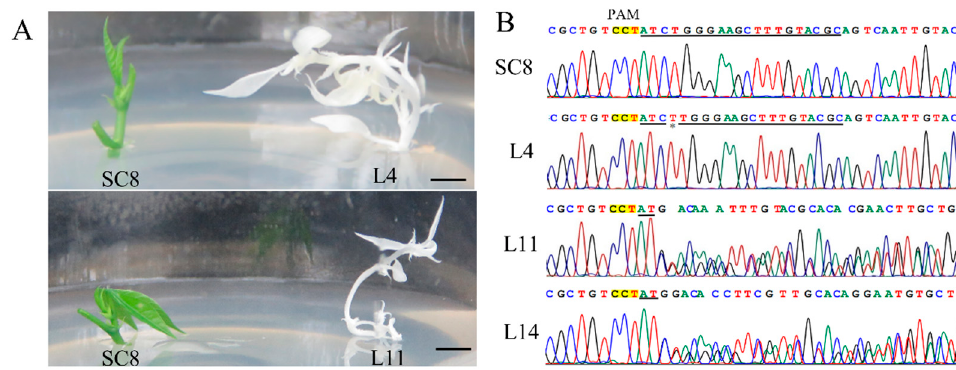
Figure 9. MePDS editing of transgenic albino SC8 cassava plants and Sanger sequences. ( A ) Albino plants and green plants of the MePDS -edited transgenic albino SC8 cassava. ( B ) Sanger sequences of the target sites in the MePDS -edited transgenic albino SC8 cassava plants.